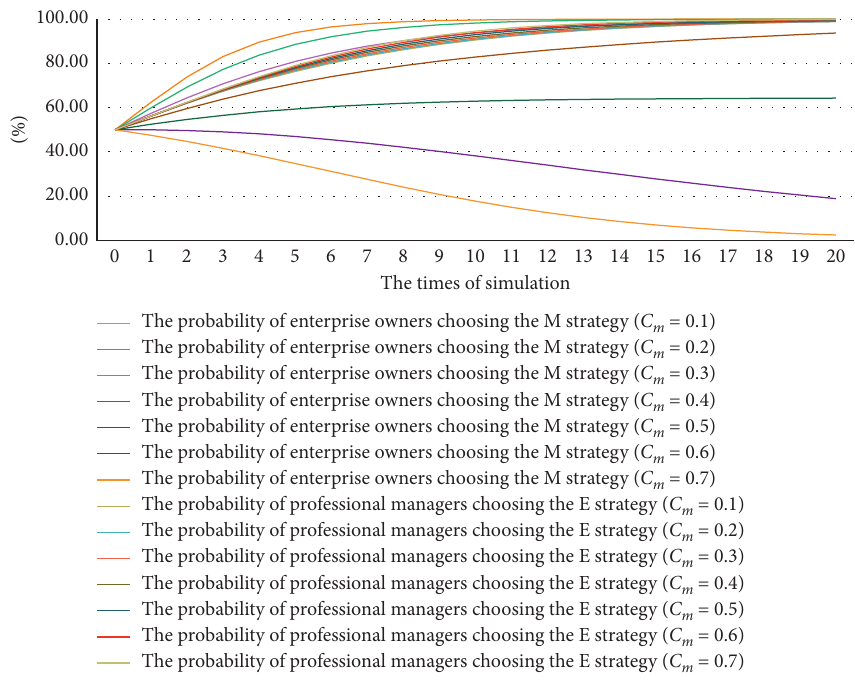
Figure 14: The impact of C m on the evolutionary